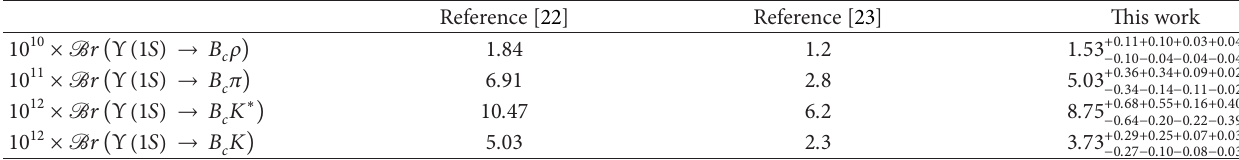
Table 4: The 𝐶𝑃 -averaged branching ratios for the Υ( 1 𝑆) → 𝐵 𝑐 𝑀